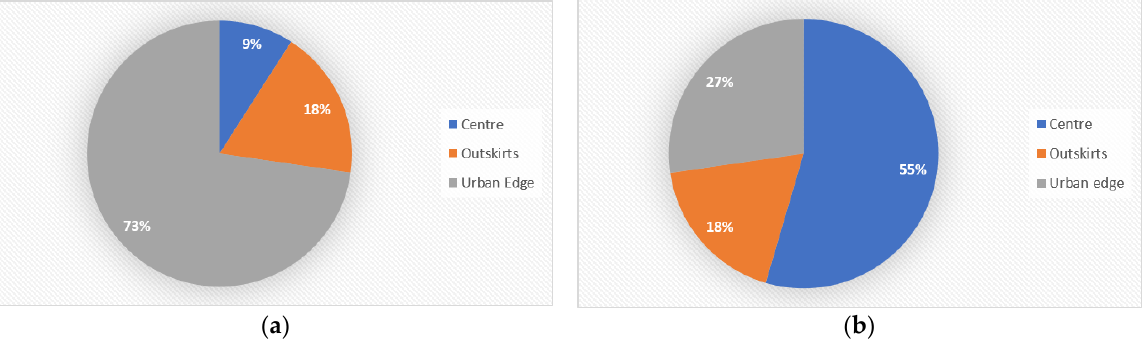
Figure 4. Graphs of the evolution of the relative position station-city: ( a ) original urban position; ( b ) current urban position. Own elaboration.